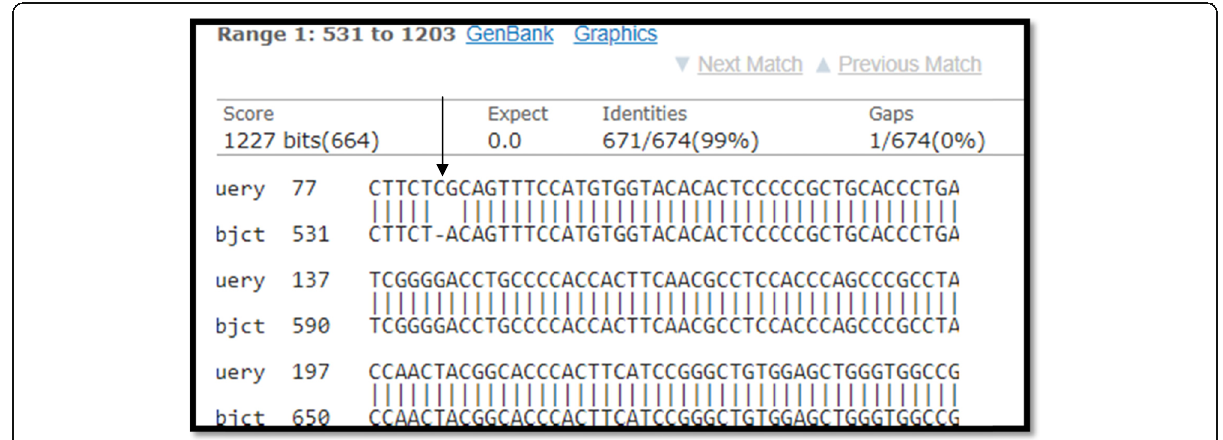
Fig. 2 Gene mutation causes a frameshift leading to an early termination/stop codon using BLAST at